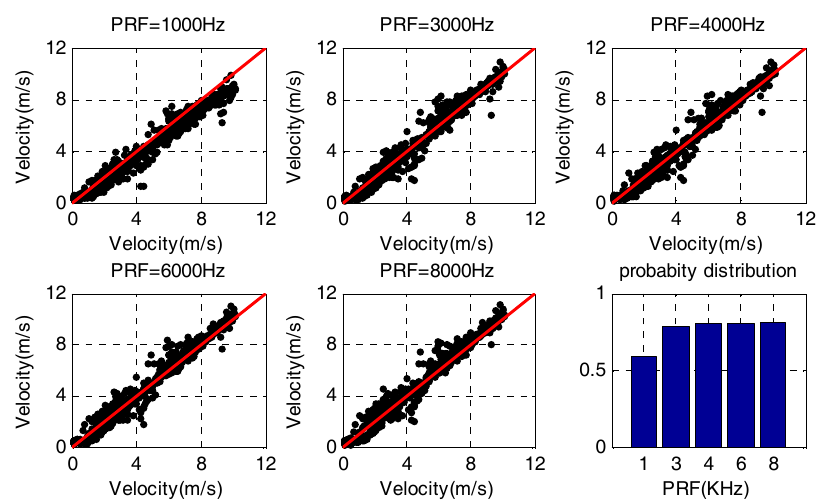
Figure 12. Velocity estimation bias and probability distribution of FDPP at different PRF. The red line in the scatter plots represents the zero-deviation standard, and the histogram indicates the probability of velocity bias being less than 0.5 m/s.